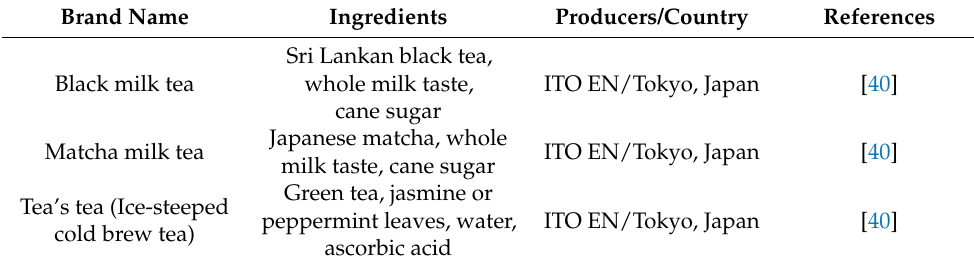
Table 1. Types of tea-based beverages in the